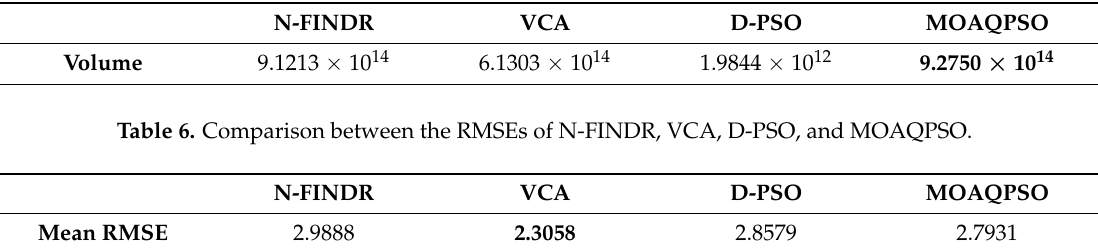
Table 5. Comparison between the simplex volumes obtained by N-FINDR, VCA, D-PSO, and MOAQPSO.